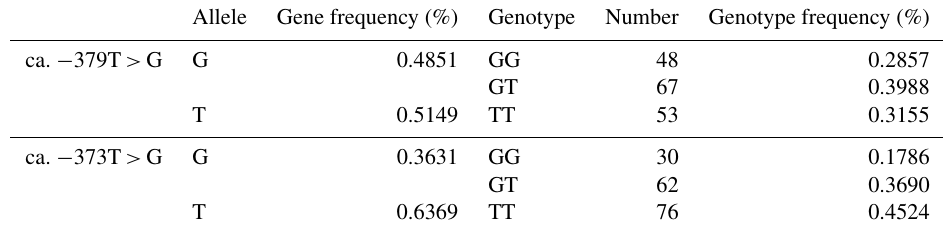
Table 2. Different genotypes at ca. − 379T > G and ca. − 373T > G in UBXN1 in the population. Allele